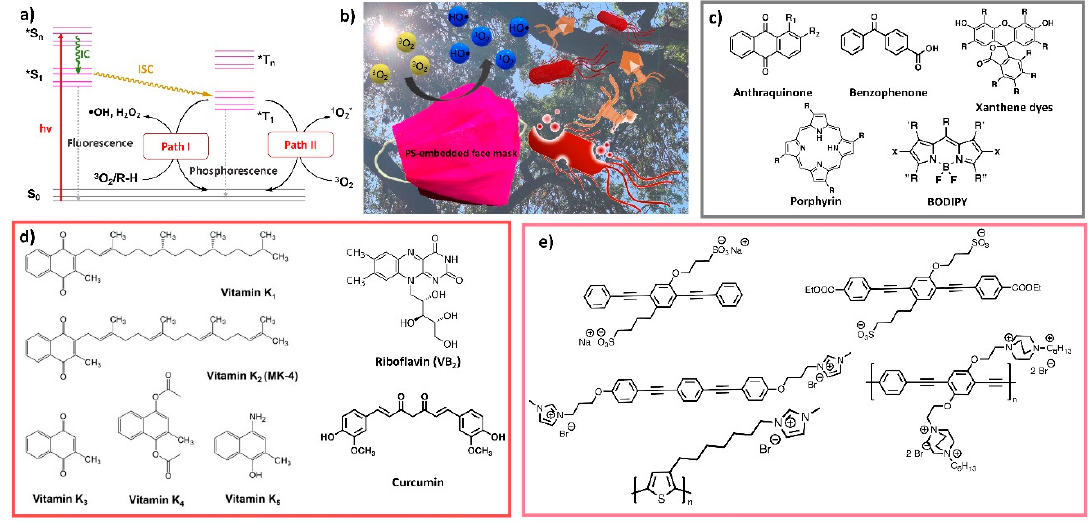
Figure 8. ( a ) Jablonski diagram illustrating the photo-excitation process of PSs. Reprinted with permission from [412] ©